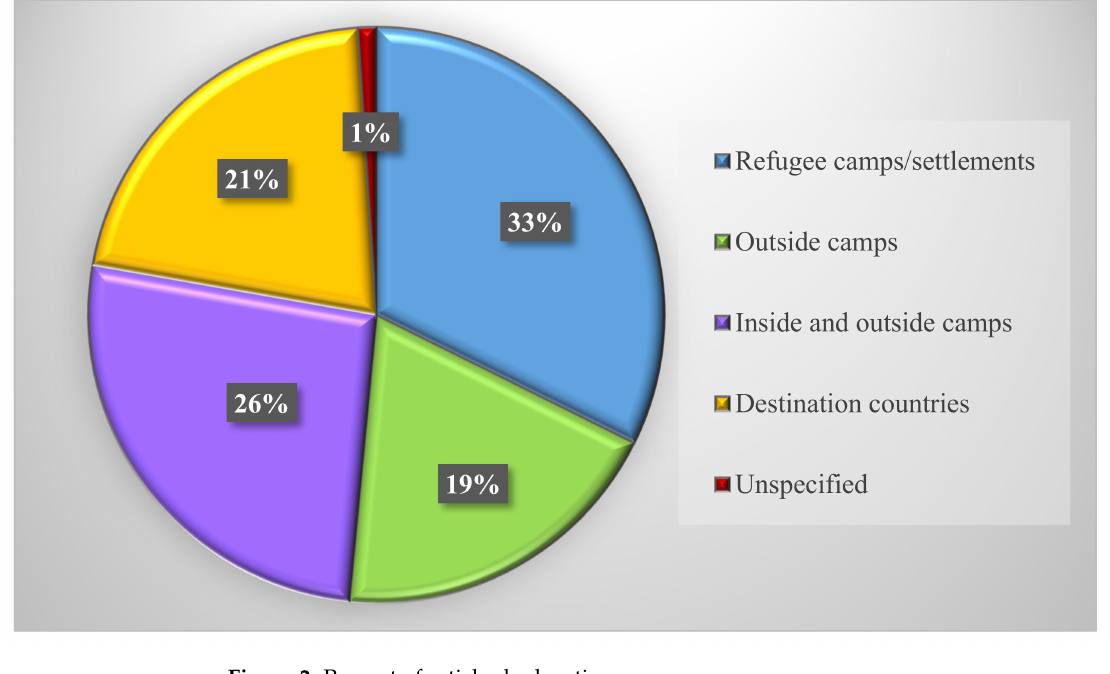
Figure 2. Percent of articles by location.